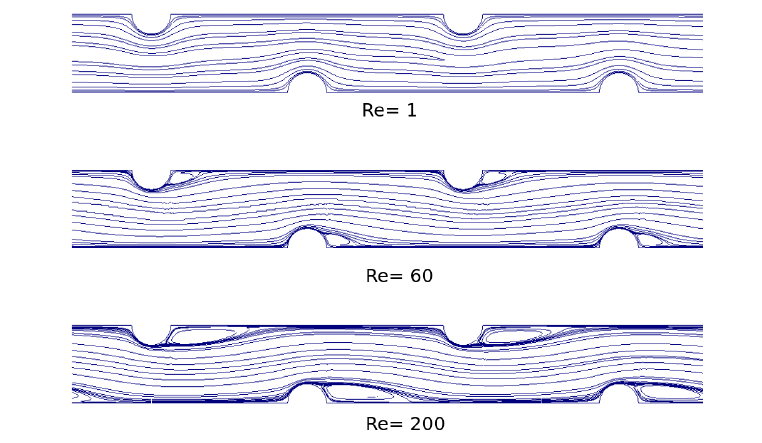
Figure 11. Comparison of the velocity streamlines along the length of the cylindrical corrugated channel for Re = 1, 60 and 200. At higher velocities (Re number), larger eddies will be created in the down stream of the